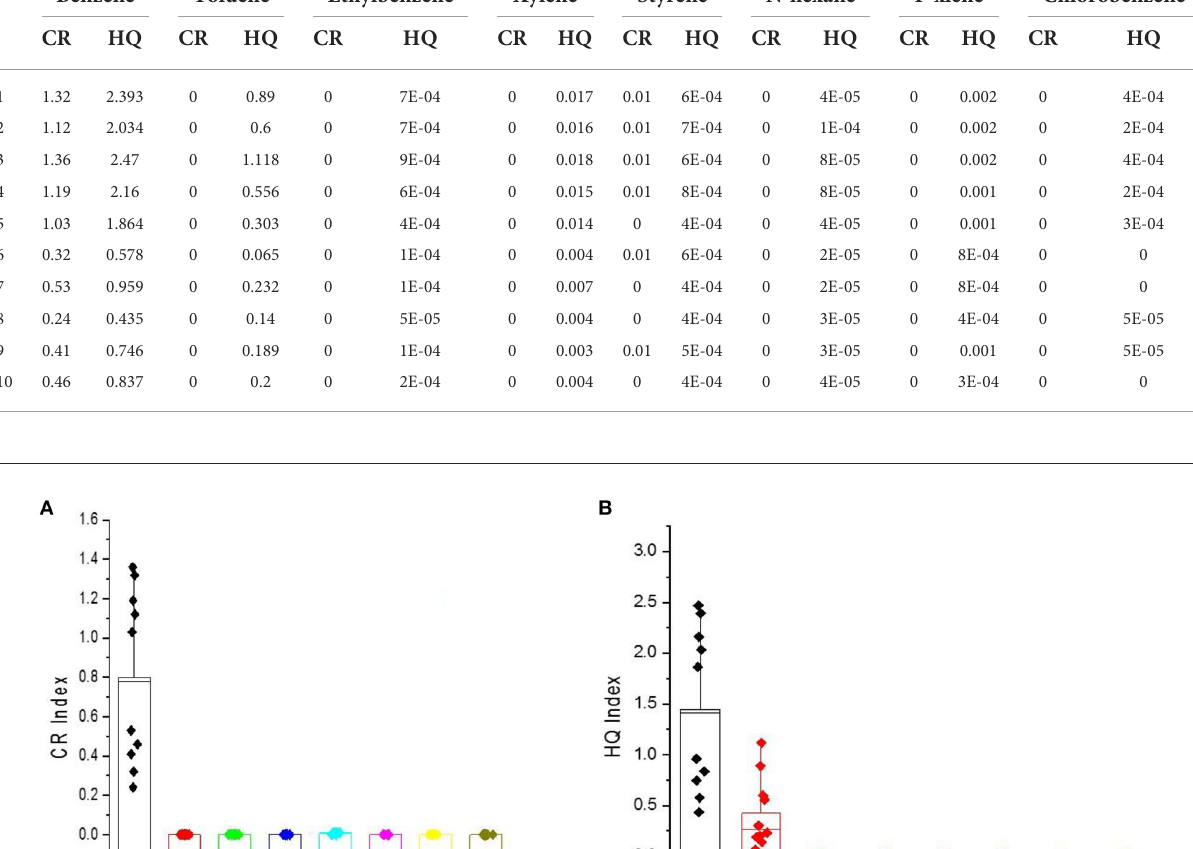
Figure 4). Due to an average uncertainty of about 10% in